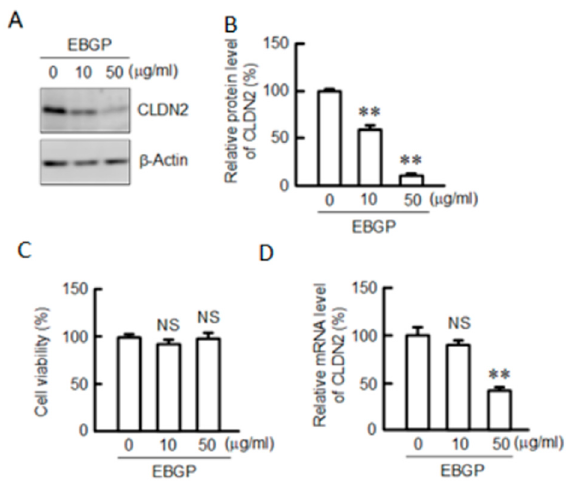
Figure 1. E ff ect of ethanol extract of Brazilian green propolis (EBGP) on the viability and expression of claudin-2 (CLDN2) in A549 cells. ( A ) Cells were incubated with 0, 10, and 50 µ g EBGP for 24 h, followed by incubation with 4-[3-[4-iodophenyl]-2-4(4-nitrophenyl)-2 H -5-tetrazolio-1,3-benzene disulfonate] (WST-1) reagent. Cell viability is represented as a percentage relative to 0 µ g / mL. ( B , C ) The cell lysates were immunoblotted with anti-CLDN2 and anti- β -actin antibodies. The protein level of CLDN2 is represented as a percentage relative to 0 µ g ( D ). The mRNA level of CLDN2 was determined by quantitative real-time PCR, and is represented as a percentage relative to 0 µ g / mL. n = 3–4. ** p < 0.01 and NS p > 0.05 compared with 0 µ g / mL (one-way analysis). Protein (F 3,8 = 201.24, p < 0.0001), viability (F 6,9 = 0.05, p = 0.953646), and mRNA (F 3,8 = 28.31, p = 0.00023).